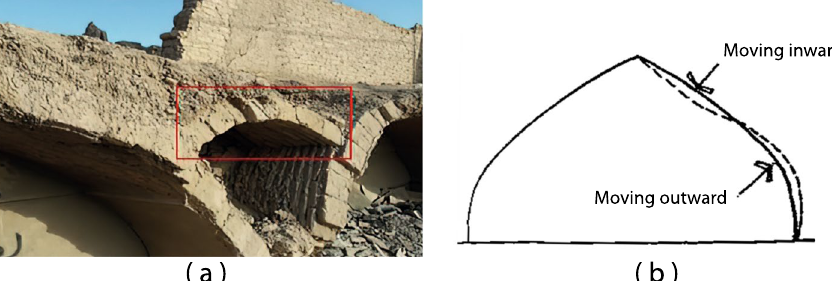
Fig. 17 Using thin vaults on the main vaults to create flat surfaces: ( a ) an instance from Yazd architecture (Source: Houshyar, Heydari, and Hemmat Zadeh 2020) and ( b ) the main vault mechanism around the Shekargah point (Source: Golabchi and Dizaji, 2016)